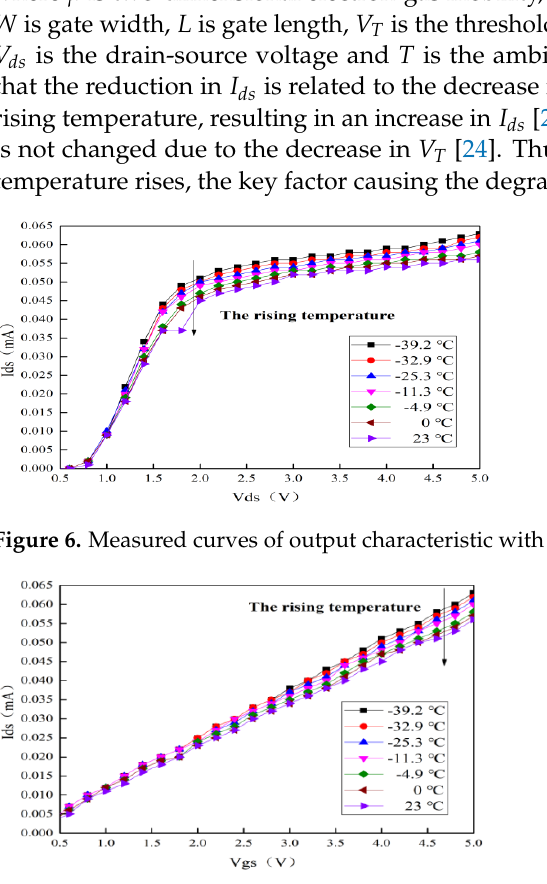
Figure 7. Measured curves of transfer characteristic with typical alpine temperatures.